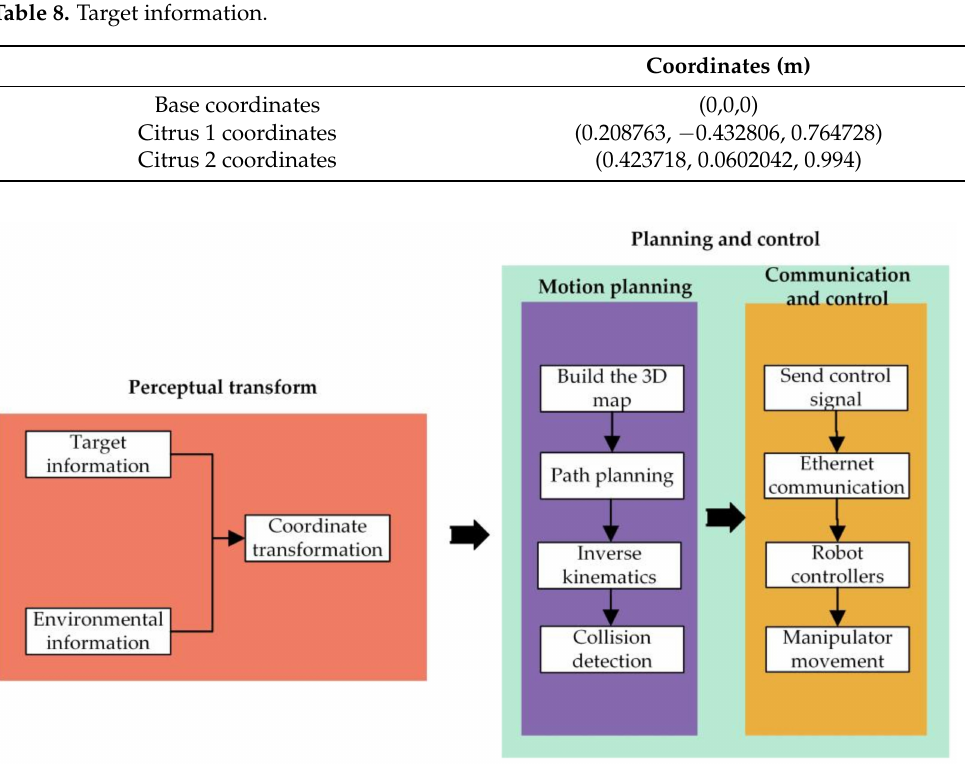
Figure 15. Control block